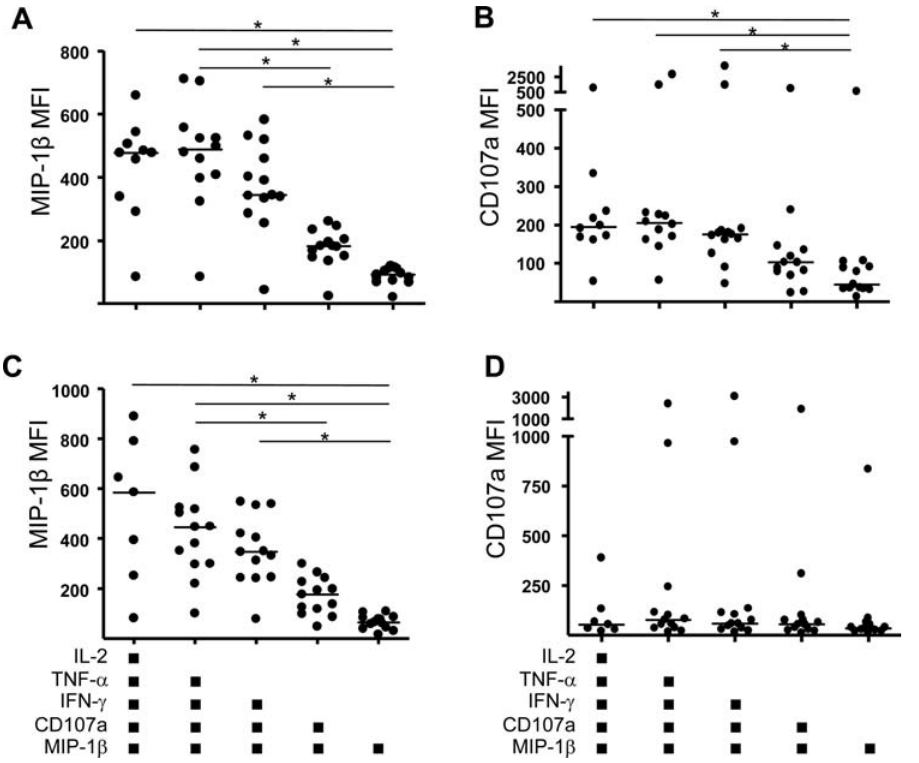
Figure 7. Median fluorescence intensity (MFI) of MIP-1 b and CD107a staining of HIVgag specific CD8 + T-cells in relation to response category. (A & B) Rectal mucosa. (C & D) Peripheral blood. Statistically significant differences (p , 0.05) are denoted by a line with an asterisk.